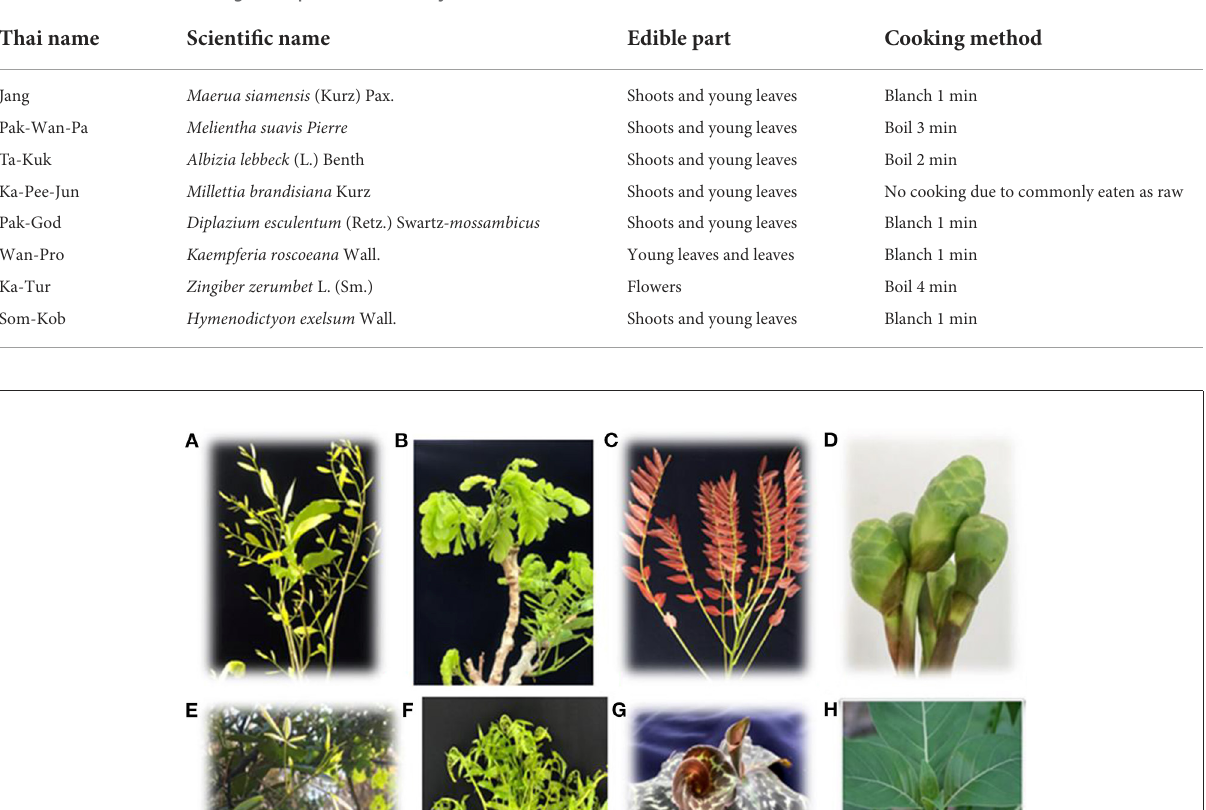
TABLE 1 List of selected indigenous plants in the